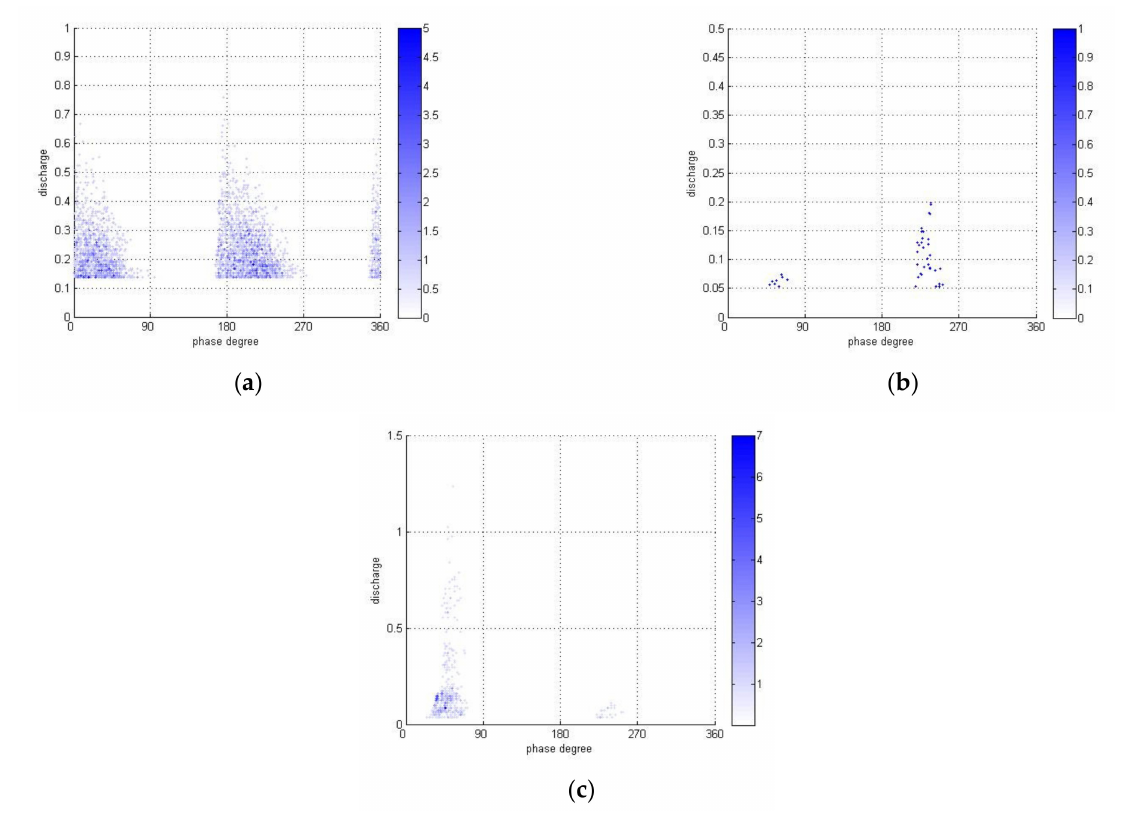
Figure 8. 26 kV n − q − ϕ patterns: ( a ) GIS 1; ( b ) GIS 2; ( c ) GIS